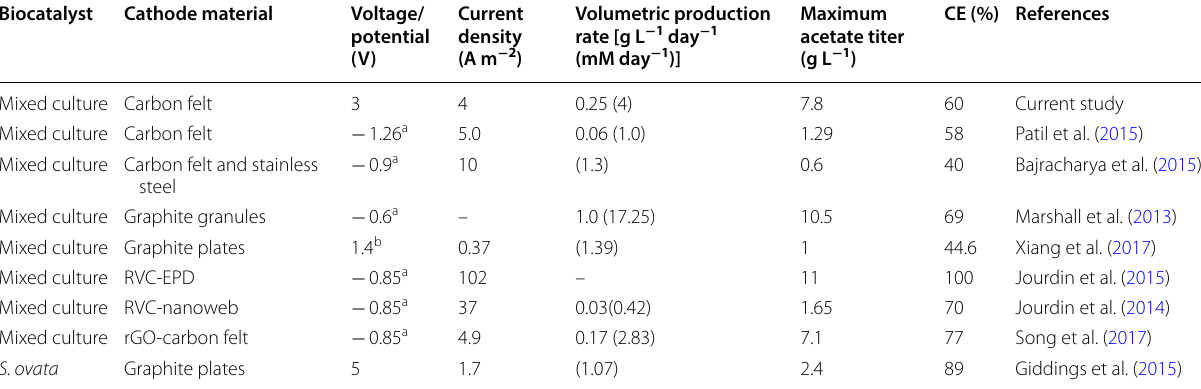
Table 2 Comparative overview of acetate production in